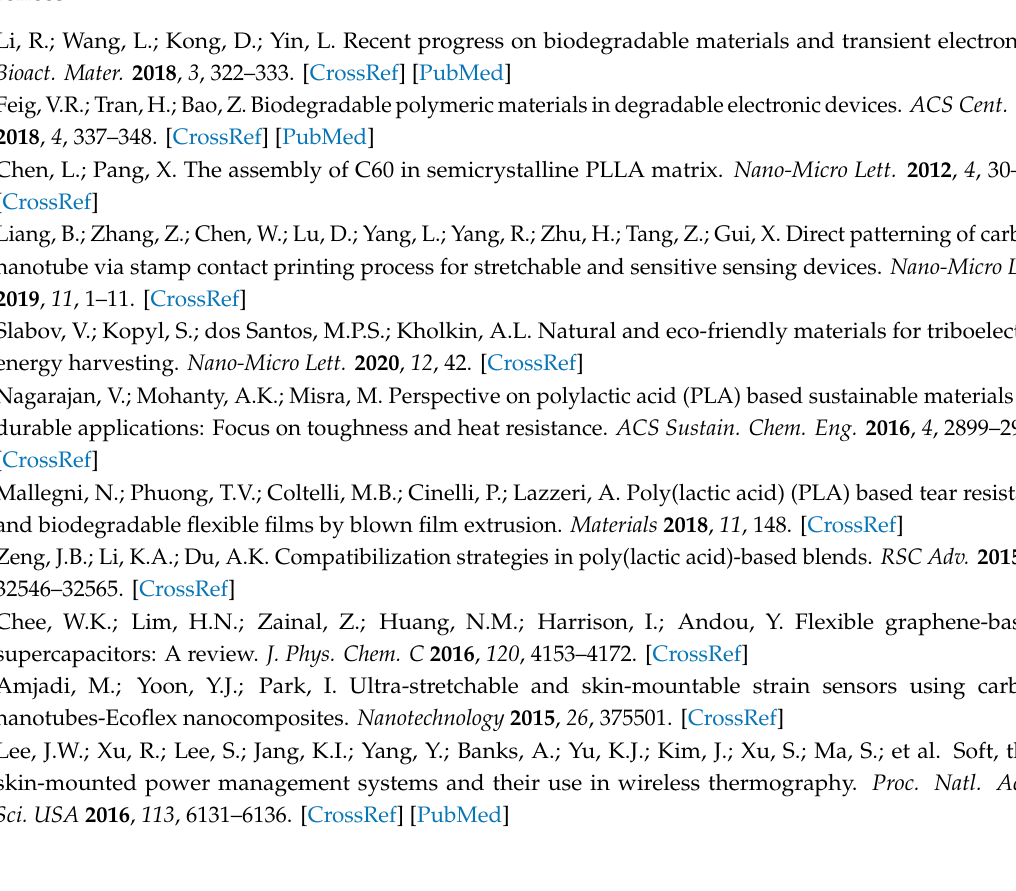
Figure S1: DSC curves registered during heating and cooling rate of 10 ◦ C / min for created hybrid layers and pure polymers, Figure S2: Optical textures of pure PCL and its hybrid layers registered with crossed polarizes and without analyser, Figure S3: Optical textures of pure Ecoflex ® and its hybrid layers registered with crossed polarizes and without analyser, Figure S4: Microscope images of layers with optical magnification of 18 × : polymers L,D-PLA, PCL, Ecoflex ® (A, B, C), polymers with 5CB in a ratio of 10:1 ( w / w ) (D, E, F), polymers with SWCN in a ratio of 10:0.01 ( w / w ) (G, H, I) and polymers with SWCN in a ratio of 10:0.5 ( w / w ) (J, K), Figure S5: Concentration-dependent solution UV–Vis spectra of the polymers (a, c, e) together with calibration curves (b, d, f)., Figure S6: Photos of polymer layers prepared by the spin-coating method, Figure S7: Absorbance and transmittance of polymer layers of L,D-PLA (a), PCL (b), Ecoflex ® (c) created by spin-coating, Figure S8: Photos of polymers (A), polymer:5CB (B), polymer:SWCN (C, D) in chloroform solution, Figure S9: Binary and ternary UV-Vis absorption solutions of polymer:5CB (a, b, c) and polymer:5CB:SWCN (d) compositions in chloroform solution together with calibration curves (e–j). UV-Vis spectra of polymers, 5CB and SWCN in chloroform with isosbestic points (k, l), Figure S10: Thermal images for films composed of on L,D-PLA, PCL, Ecoflex ® (a) and their selected mixtures with 5CB or SWCN (b), at 2.0 V, 6.0 V and 10.0V, Table S1: Selected UV-Vis properties of polymers and binary and ternary